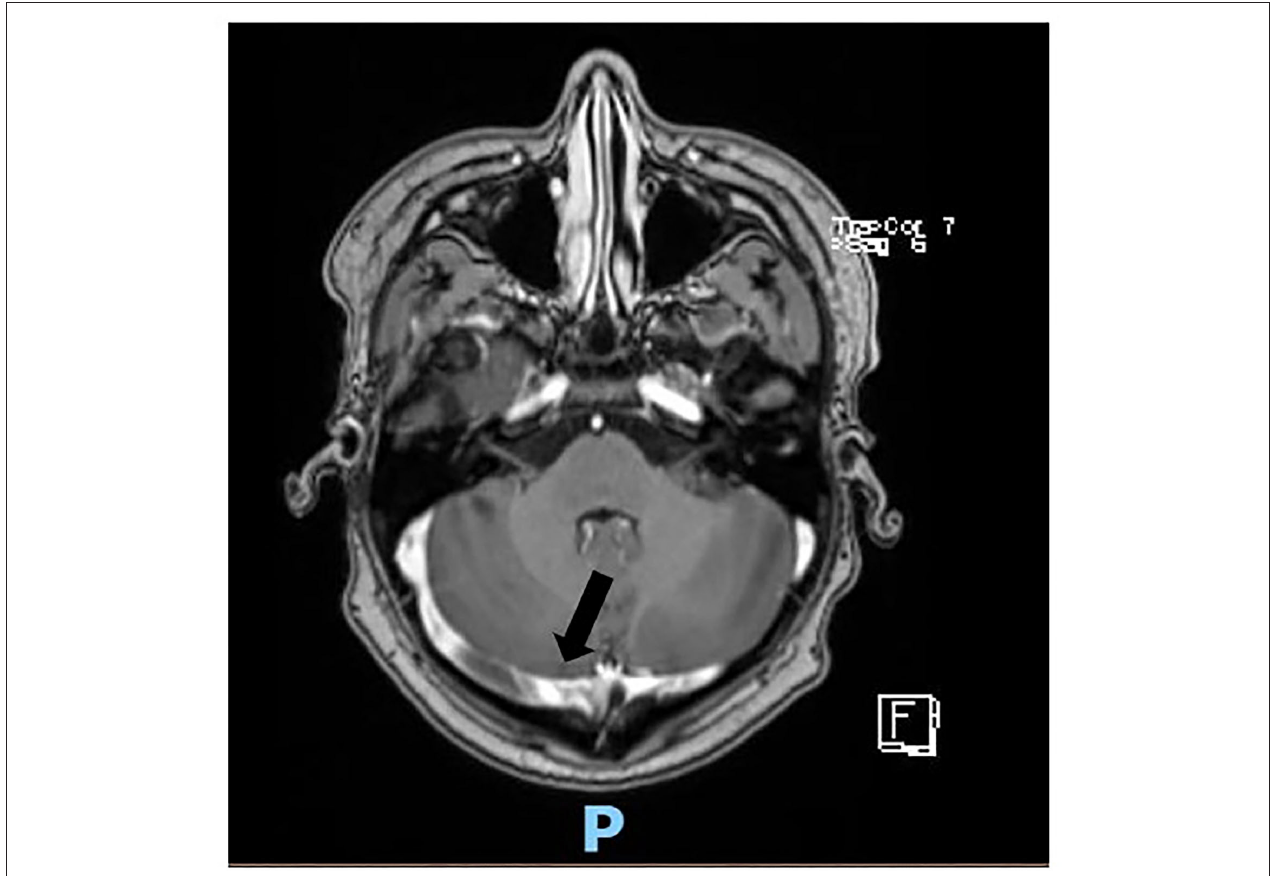
FIGURE 1 | Axial scan of magnetic resonance showing thrombosis of the transverse-sigmoid sinuses of both sides (black